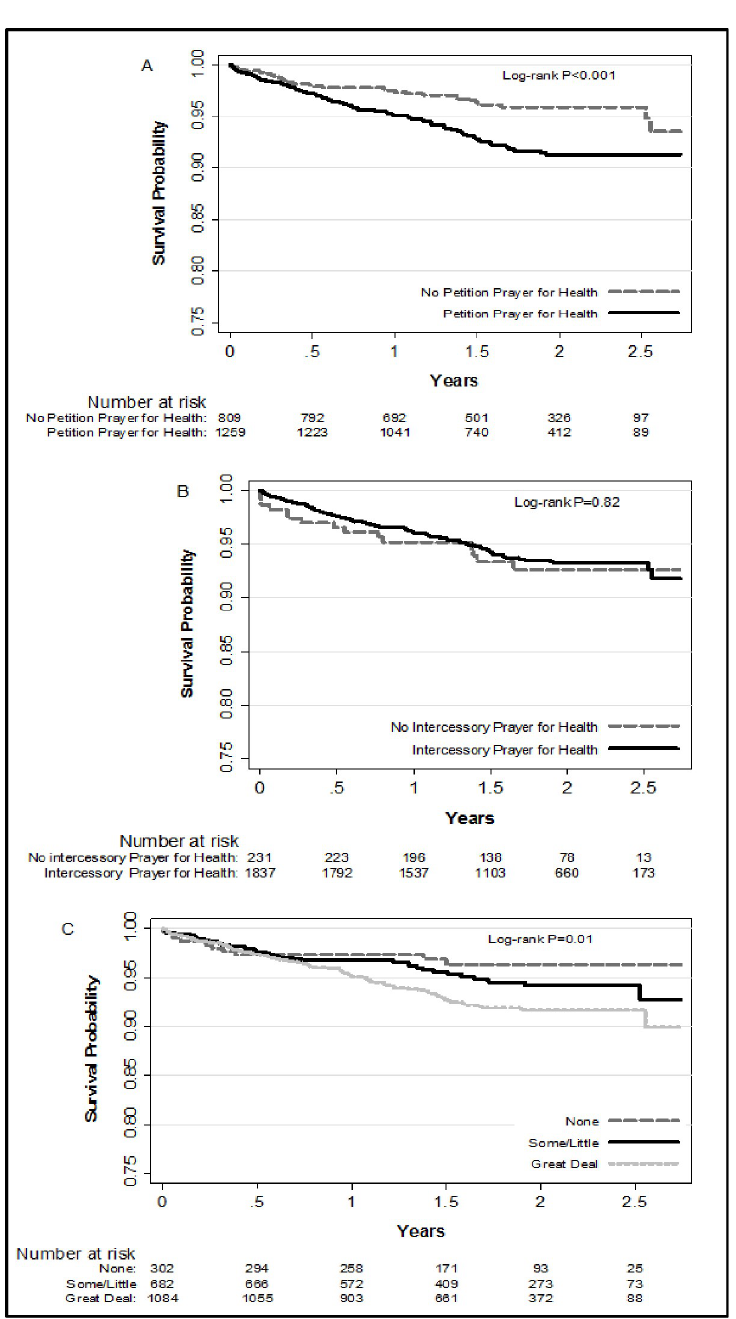
Fig 1. Kaplan-Meier survival curves for patients who survive at least 2 years after hospital discharge for an acute coronary syndrome according to the three measures of religiosity. (A) No petition prayer for health/Petition prayer for health. (B) No intercessory prayer for health/Intercessory prayer for health. (C) Strength and comfort from religion (None, Some/Little, Great Deal). After accounting for sociodemographic characteristics (age, sex, and race/ethnicity), petition prayer for health was associated with an increased risk of 2-year all-cause mortality (HR: 1.64; 95% CI: 1.01–2.66). With further adjustment for several clinical and psychosocial variables,